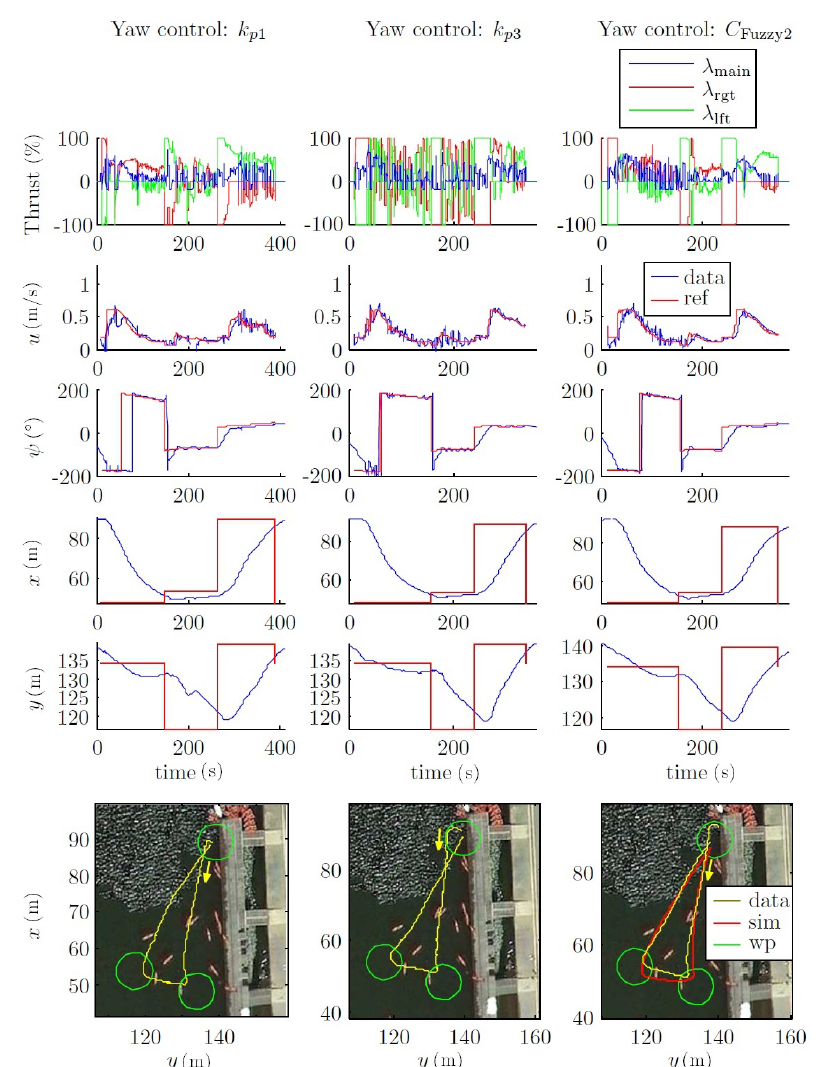
Figure 26. Field tests. Outer loop fuzzy control. Comparison of C Fuzzy 2 with proportional controllers. Path 1. u = 0.6 m/s. Where data is the real data acquired during the test, sim is the simulation results, and wp are the way-points to